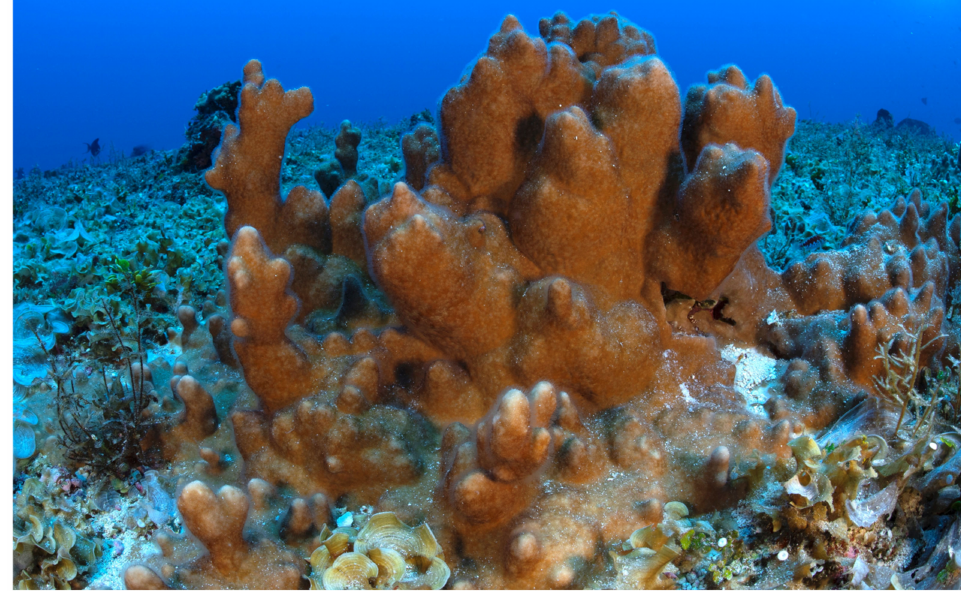
Figure 1. Millepora aff. exaesa at 65 m on Mount La P é rouse, Southwestern Indian Ocean. Photo credit: Laurent Ballesta/Androm è de Oc é